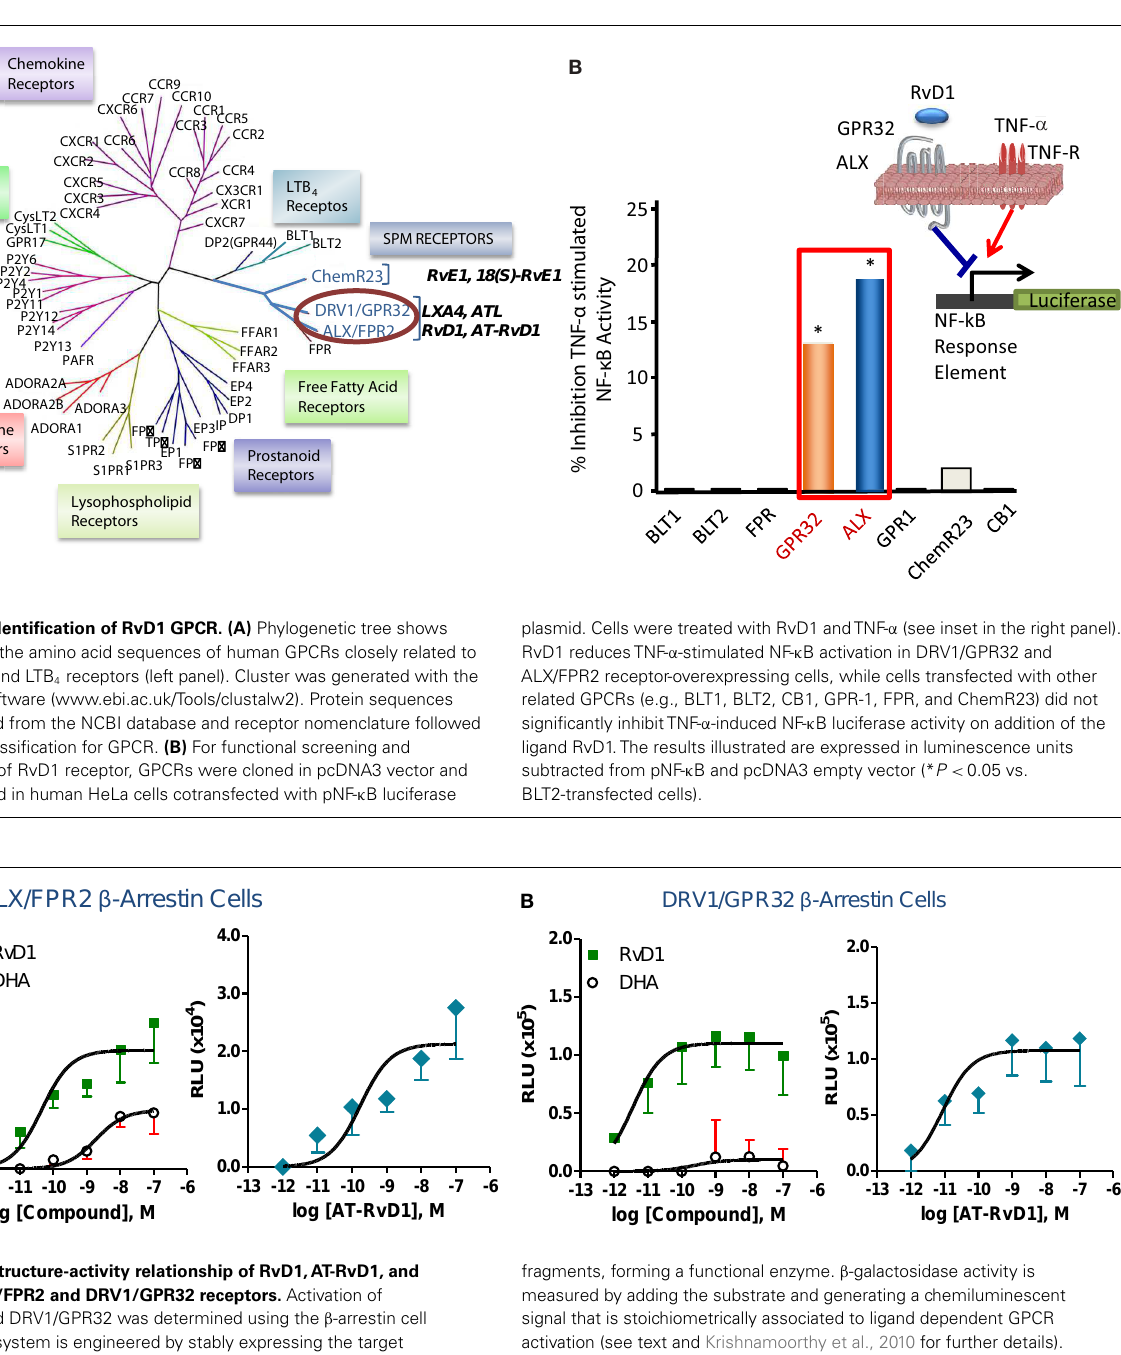
fragments, forming a functional enzyme. β -galactosidase activity is measured by adding the substrate and generating a chemiluminescent signal that is stoichiometrically associated to ligand dependent GPCR activation (see text and Krishnamoorthy et al., 2010 for further details). Dose-response curves show activation of ALX/FPR2 (A) and DRV1/GPR32 (B) receptors by RvD1, AT-RvD1, but not DHA determined using the β -arrestin cell system. Results are mean ( ± SEM) from n = 4 to 6. RLU, relative luminescence